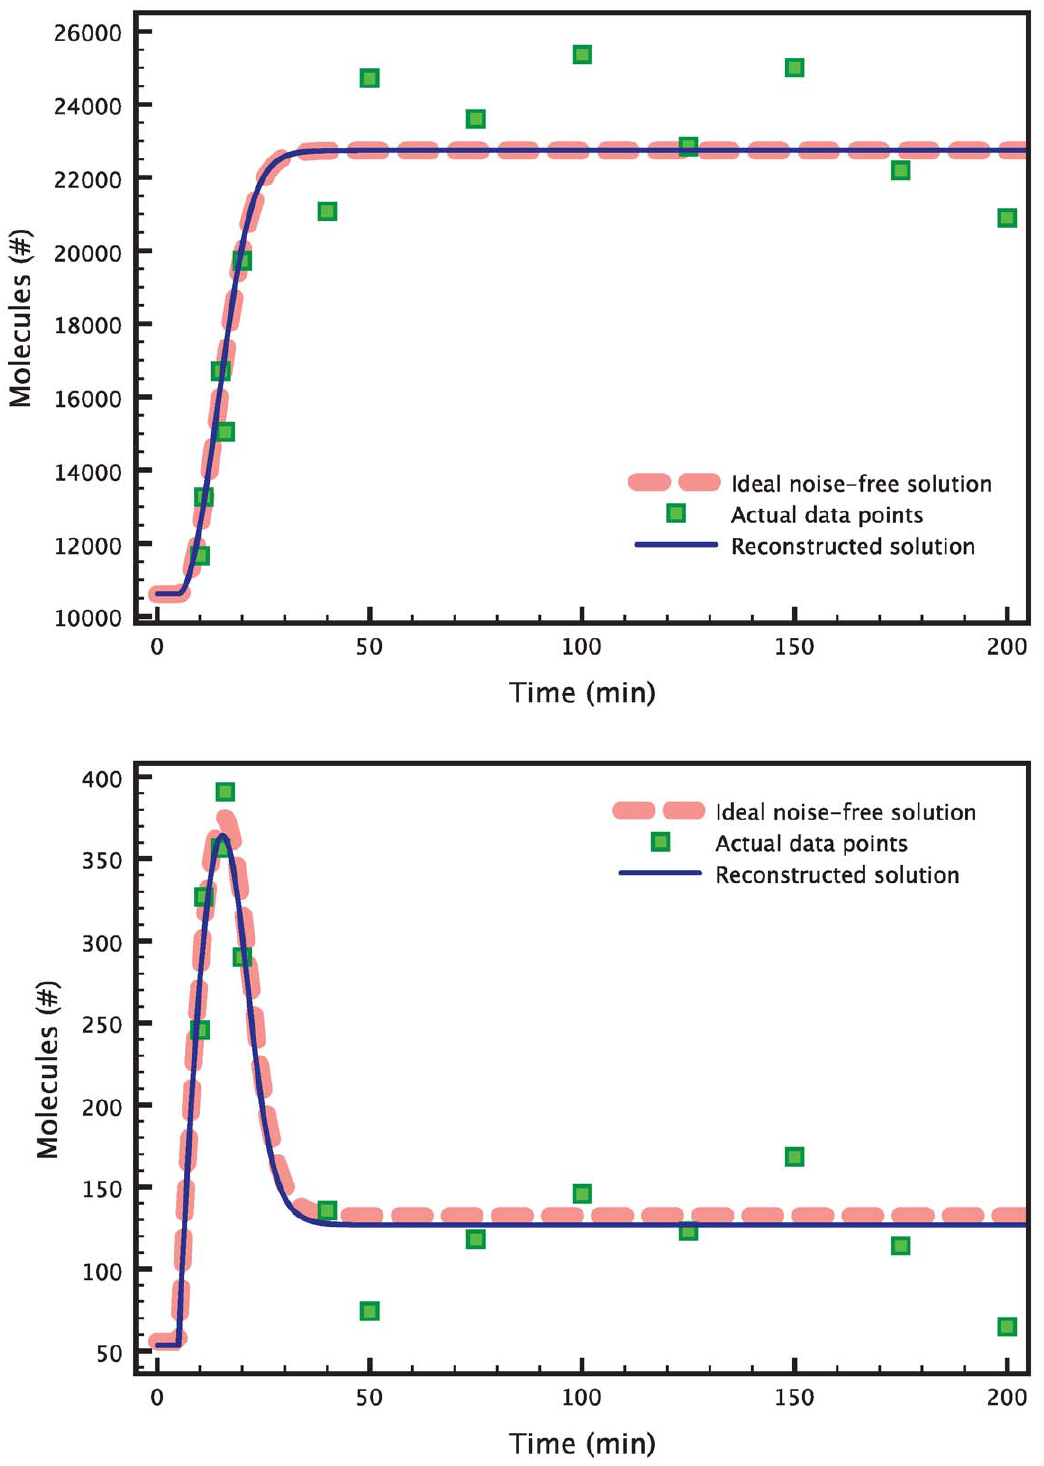
Figure 2. Estimation of 2 parameters in the heat shock model. The data points (green squares) are obtained by evaluating the true model solution (red dashed curve) at the chosen time points, and then adding white Gaussian noise. The blue solid line shows the reconstructed solution corresponding to the HEKF estimates for the parameters a s and K d . Both the reconstructed measurement signal for D t (top) and the one for S t (bottom) are very close to the respective true solutions. The graphs are zoomed to highlight the transient response of the heat shock system after a temperature increase.